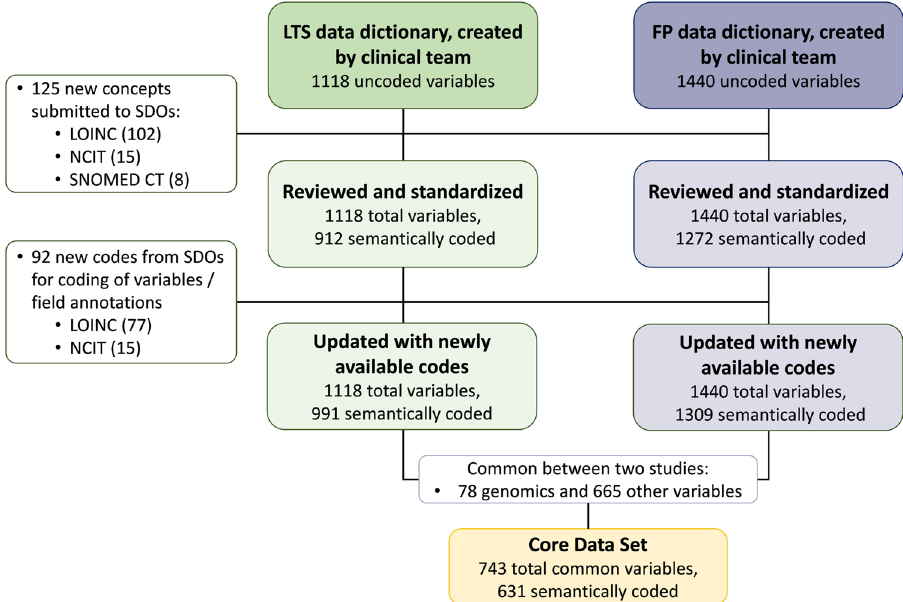
Fig. 4 Overview of harmonized data and submissions to standard developing organizations. The diagram shows a summary of the variables used and semantically coded in the case report forms of the LTS and FP clinical studies and the concepts submitted for coding to standard developing